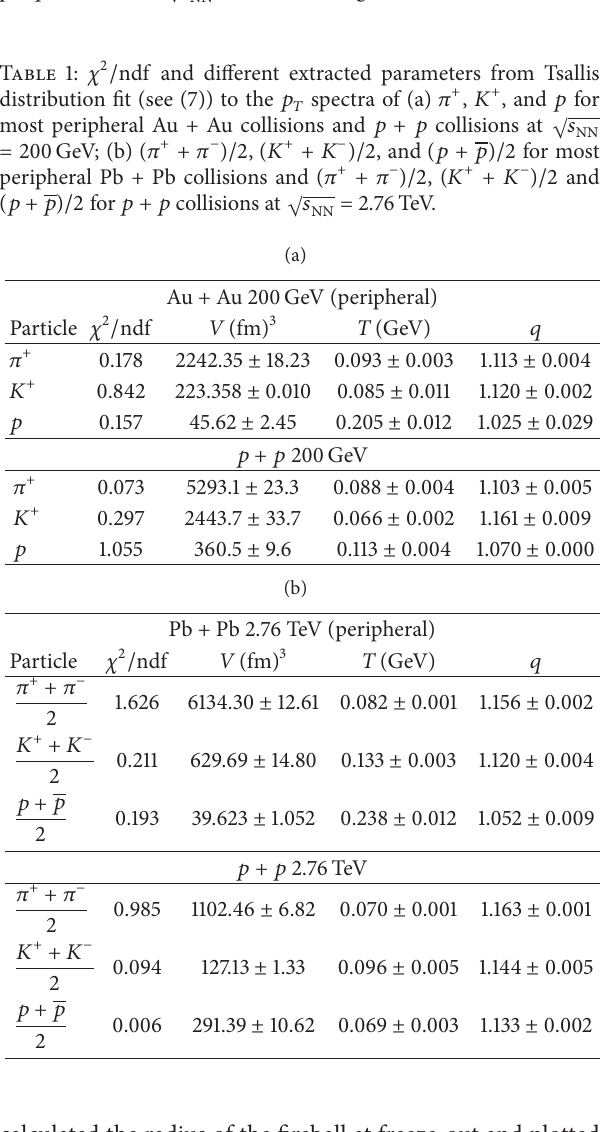
Figure 2: 𝜒 2 / ndf values are shown for most peripheral Pb + Pb and 𝑝 + 𝑝 collisions at √𝑠 NN = 2.76 TeV using (7) as a fit function.